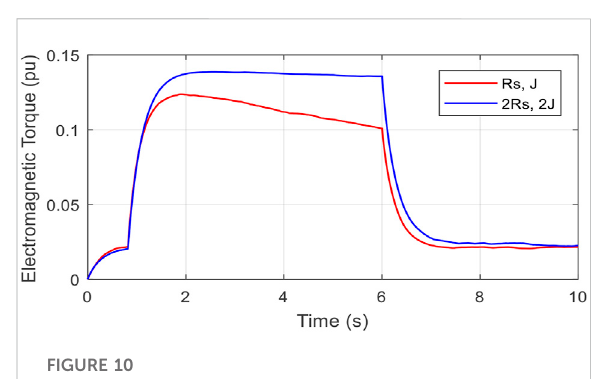
FIGURE 12 DC-link voltage under parameter